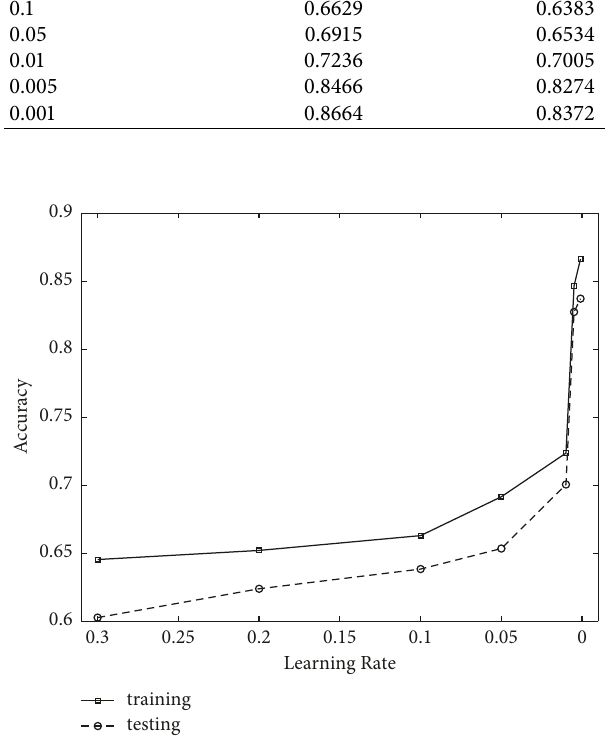
Figure 7: Learning rate